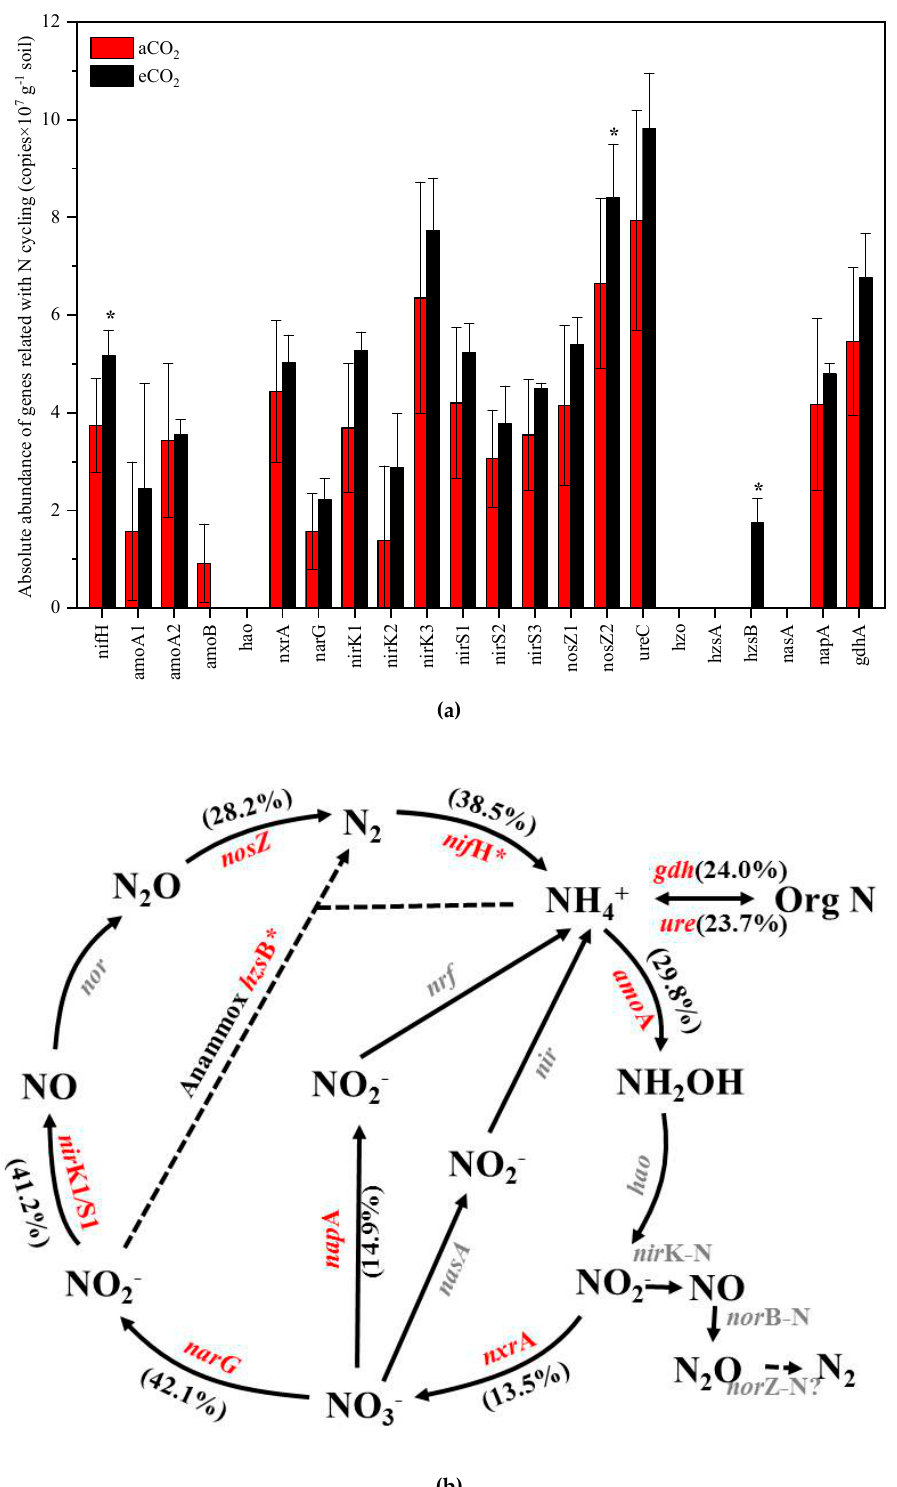
Figure 5. ( a ) Absolute abundance of genes related with N cycling under aCO 2 and eCO 2 . ( b ) The scheme of N cycling. In figure ( b ), for each functional gene, colors mean that this gene had a higher (red) abundance at eCO 2 than at aCO 2 with significance at p < 0.05 (*). Gray-colored genes were not targeted by this microarray or not detected in those